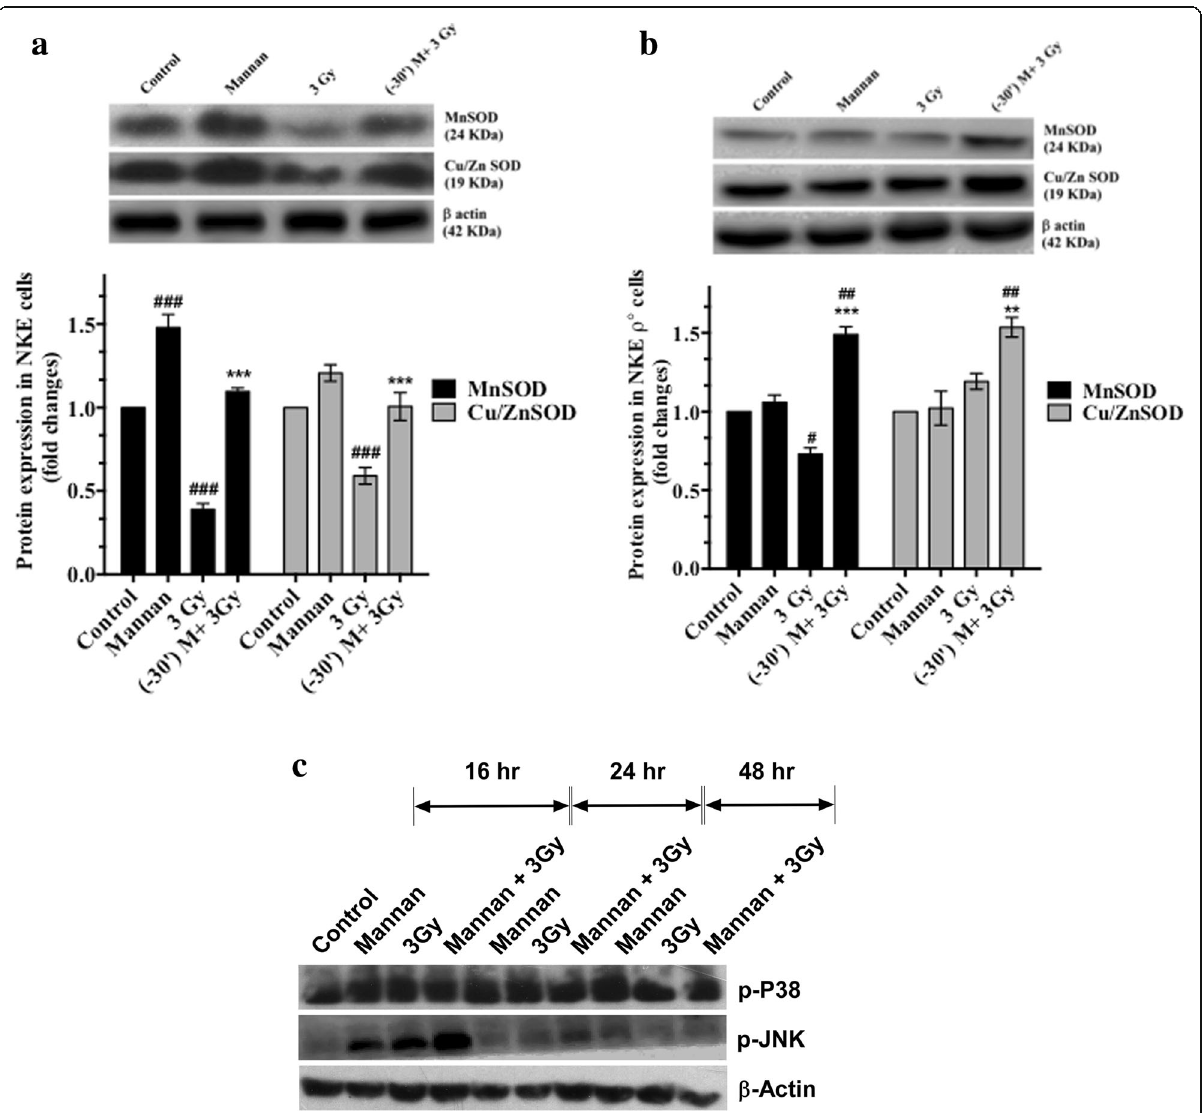
gradient SDS-polyacrylamide gel followed by transfer on to PVDF membrane and blotted using specific antibodies as described in materials and method section. β -actin was used as a loading control. Results are expressed as Protein expression (fold changes) with respect to control ±SD. Differences were designated significant at values, *** p < 0.001 and were labeled as # compared with the sham irradiated control group, * compared with the 3 Gy (radiation only) group. ( c ) Phosphorylation of JNK and P38. To assess role of stress response pathways in mannan mediated protection activation of JNM and P38 was measured as phosphorylation status. Briefly, cells were harvested, and equal quantity of corresponding primary and secondary antibodies as described in materials and methods section. The changes in phosphorylation were compared with radiation and sham irradiation groups at different time intervals. β -actin was used as a loading